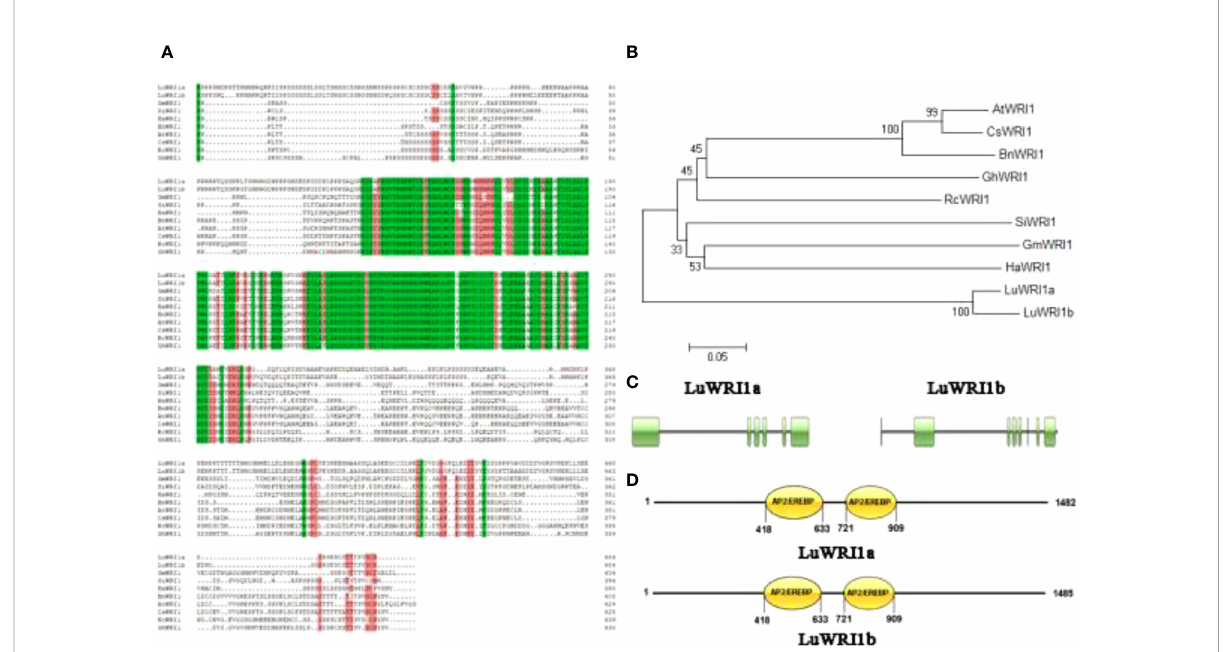
FIGURE 1 Amino acid sequence alignment and phylogenetic analysis of LuWRI1a and LuWRI1b (A) Sequence alignments of LuWRI1a, LuWRI1b, GmWRI1, SiWRI1, BnWRI1, HaWRI1, AtWRI1, CsWRI1, RcWRI1, GhWRI1, CeWRI1, EgWRI1, CnWRI1, and ZmWRI1 proteins. Conserved AP2/EREBP DNA binding motifs (in green) and the “ VYL ” motif (in orange) that activates WRI1 transcription. (B) Phylogenetic tree of WRI proteins. The neighbor- joining approach was used to construct a phylogenetic tree in MEGA6. AtWRI1 (AT3G54320.1), CsWRI1 (AQP31129.1), BnWRI1 (ADO16346.1), GhWRI1 (AFV61655.1), RcWRI1 (NP_001310691.1), SiWRI1 (XP_011078716.1), GmWRI1 (ADM34977.1), and HaWRI1 (AFQ93679.1). (C) The amino acid and nucleotide sequences of LuWRI1a and LuWRI1b were fi gured out. (D) The conserved domains of LuWRI1a and LuWRI1b. Numbers indicate the amino acid positions along the protein. Double AP2/EREBP domains were predicted in two